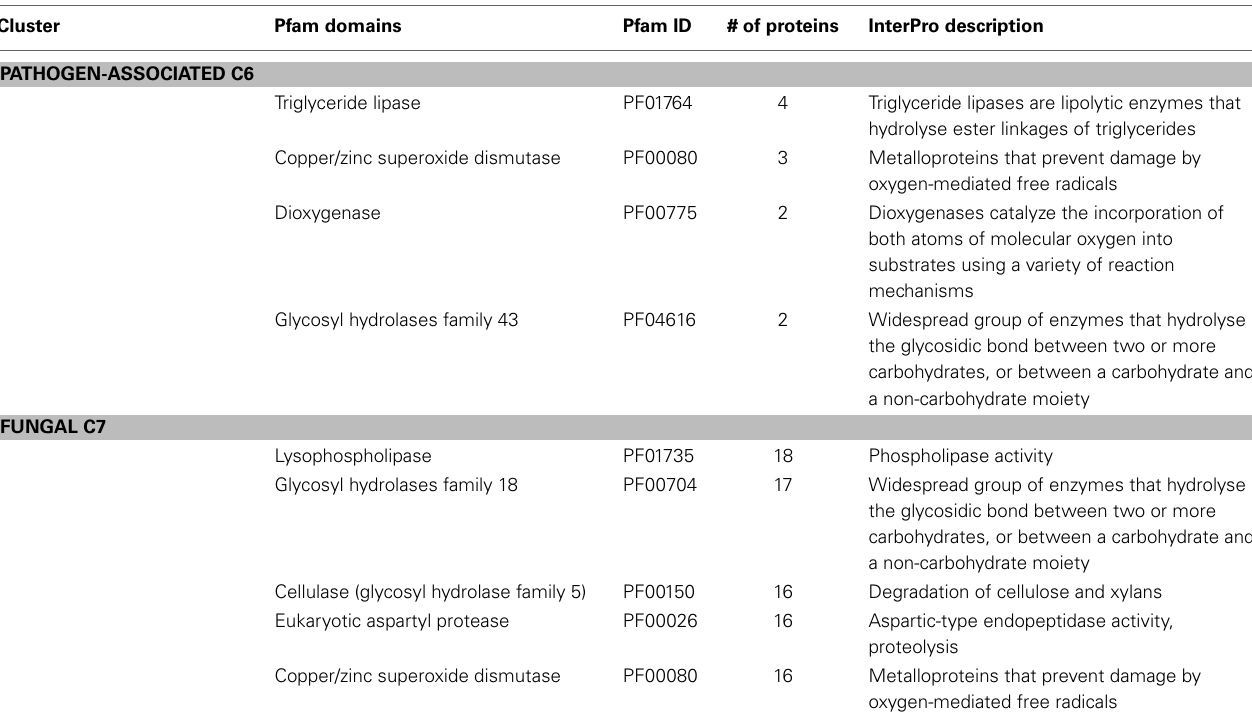
Table 2 | The most frequent Pfam domain hits are shown for the two clusters with an enriched secretion signal across the pathogen-associated and fungal gene families.